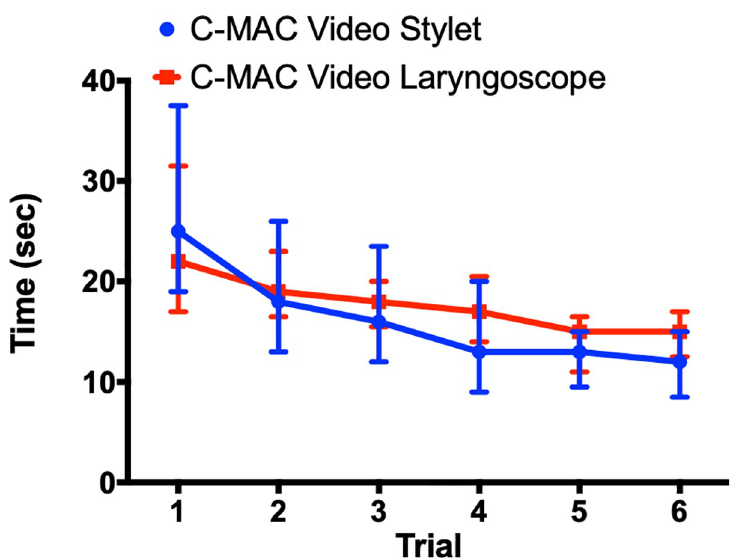
Fig 2. Learning curves in a normal airway ( n = 21). Learning Curve for C-MAC Video Stylet and C-MAC Video Laryngoscope; median with 95% confidence interval. Comparison by two-way ANOVA confirmed trial number as a statistically significant interaction: device effect, p = 0.83; trial number effect, p <